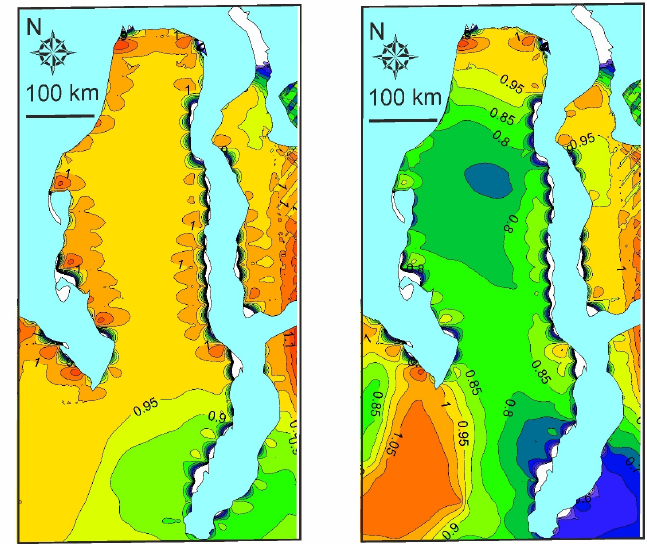
Figure A1. Ratios of C v values for different types of sequences of annual maximum snow pack depth. The left is C v for the years 1985–2019 with linear trend excluded divided on C v for the years 1985–2019 with trend; the right is C v for the years 1985–2013 divided on C v for the years 1985–2019, both sequences with the linear trend excluded.